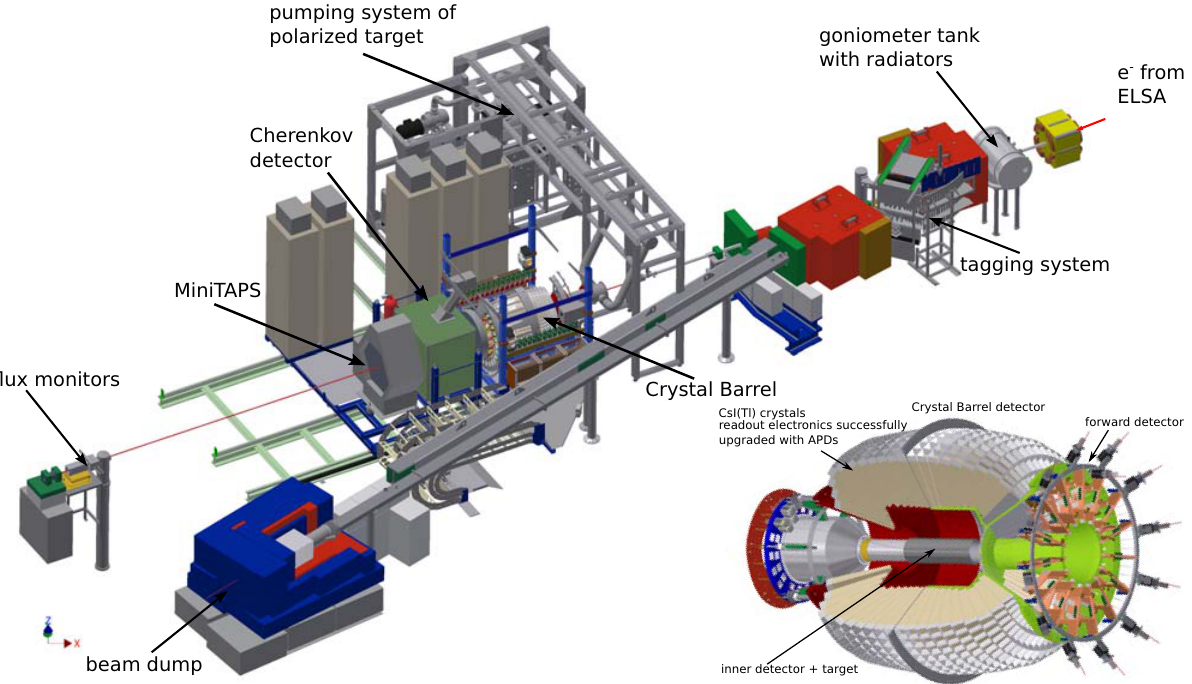
Figure 1. Overview of the CBELSA / TPAS experimental area. The electron beam from ELSA (upper right corner) impinges a thin radiator inside the goniometer tank and a photon beam is produced via bremsstrahlung. The photon energy can be determined with the tagging system that deflects the scattered electrons according to their momenta and detects them via scintillation fibers and bars. The photons hit a target at the center of the Crystal Barrel calorimeter, which is shown in large in the right bottom corner. It is complemented by the MiniTAPS detector in forward direction. The inner detector, which consists of scintillation fibers, and the scintillation plates, that are mounted in front of the forward crystals, are utilized for the identification of charged